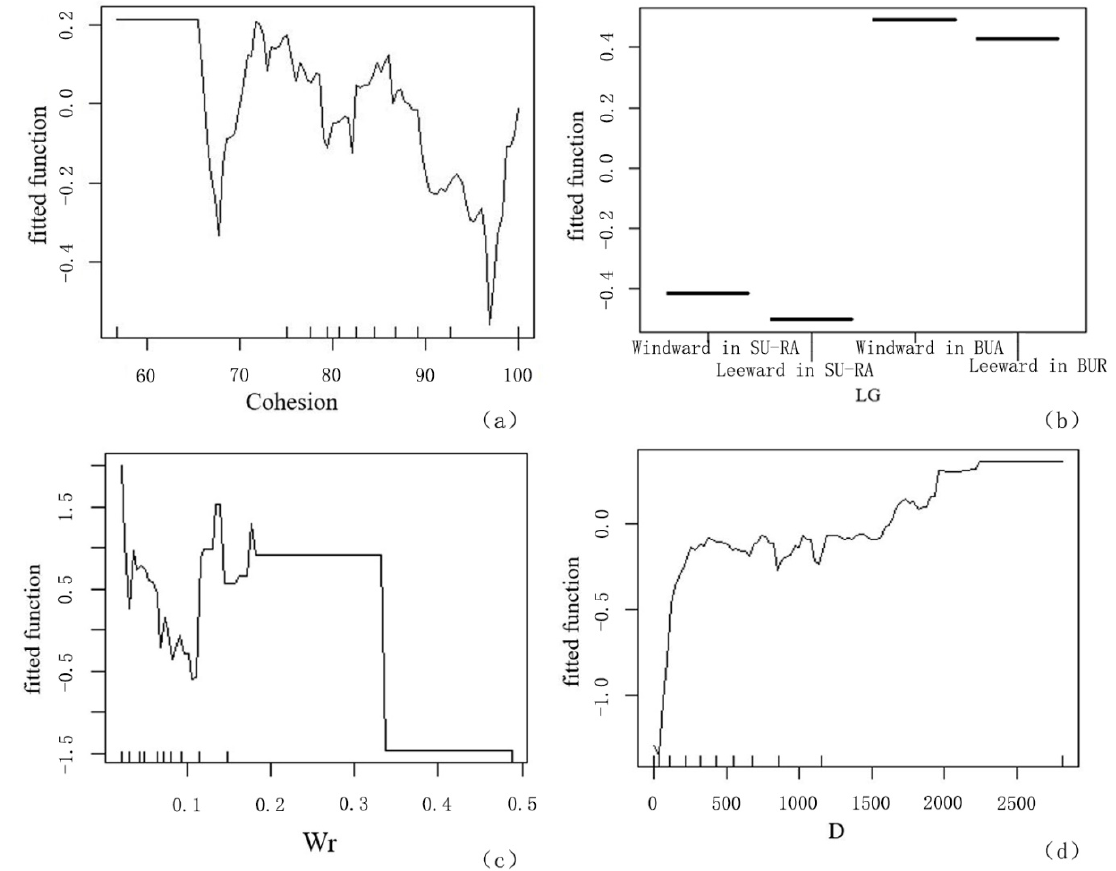
Figure 10. ME curve of structural factors of blue ‒ green space on LST. ( a ) Distance from riverbank; ( b ) location; ( c ) Wr; ( d ) ( b ) location; ( c ) Wr; ( d ) cohesion.